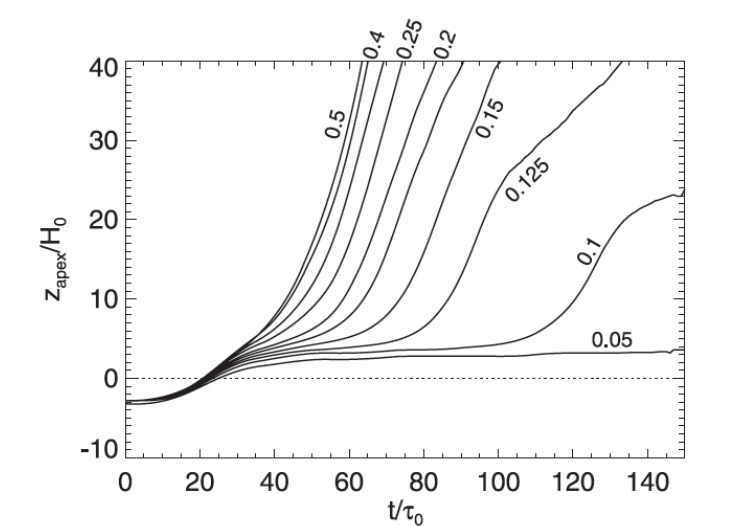
Figure 24: From the parameter study of twisted flux tube emergence, a plot showing the height of the tube apex as functions of time and magnetic twist ( 𝑞 ). With sufficiently weak twist ( 𝑞 = 0 . 05), the tube is trapped in the photosphere. For twist 𝑞 = 0 . 1 and higher, the magnetic field is launched into the corona due to magnetic buoyancy instabilities. The time delay between arrival at photosphere and passage into the corona decreases with increasing twist. Image reproduced with permission from Toriumi et al. (2011), copyright by